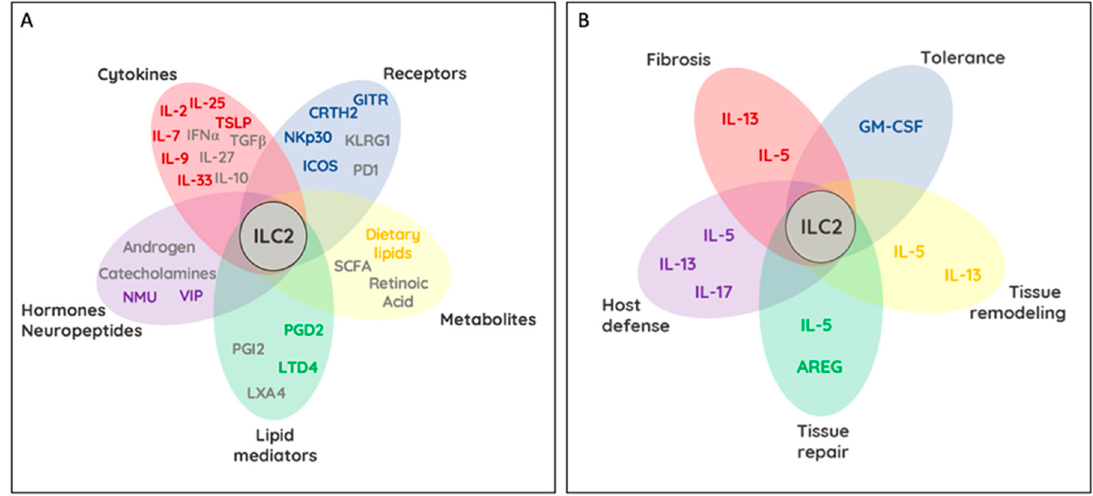
Figure 2. Regulation of ILC2 functions and ILC2-dependent control of host tissues. Schemes demonstrate in ( A ) molecules and receptors involved in ILC2 activation (colored) and ILC2 inhibition (grey). Bubbles within the Venn-diagram like schemes represent subclasses of activating and inhibiting molecules (Cytokines—red; non-cytokine, surface receptor—blue; dietary metabolites— yellow; lipid mediators—green; neuropeptides and hormones—violet). Overlaying bubbles indicate possible synergistic and antagonistic actions of these molecules that in sum positively and negatively regulate ILC2 activation. Scheme ( B ) demonstrates the effects of ILC2 activation on tissues and immunity. Selective cytokines and cytokine groups are indicated. Tissue remodeling, tissue repair, host defense, fibrosis, as well as immune and disease tolerance require selective and context dependent actions of IL-5, IL-13, IL-17, AREG, and GM-CSF. Overlap between individual bubbles within the Venn-diagram further suggest possible transitions between tissue-regulatory effects by ILC2.